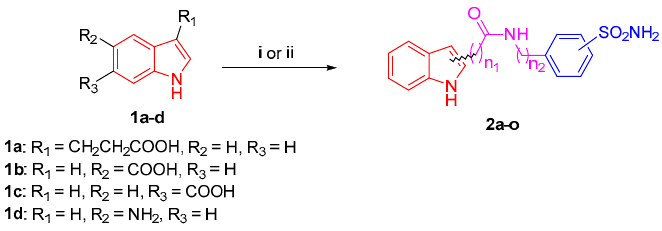
Table 1. Starting materials, reagents, and chemical structures of compounds 2a – o . Cpd